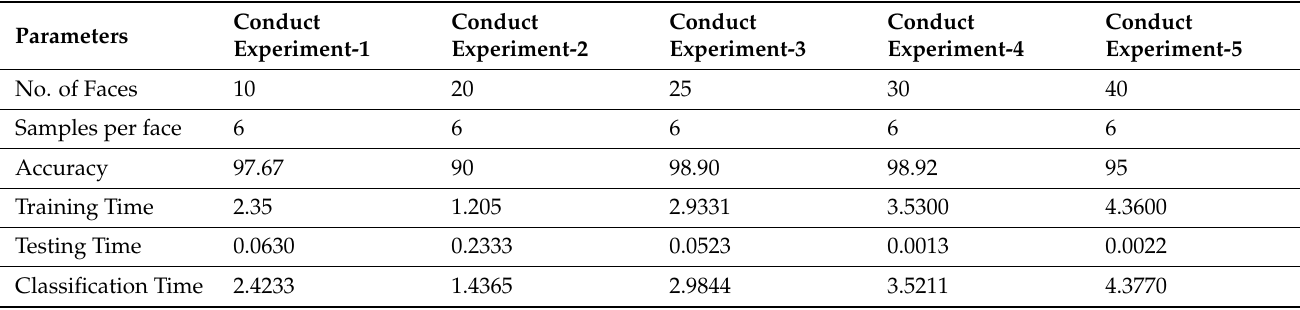
Table 2. Results analysis using the DCT-SVM